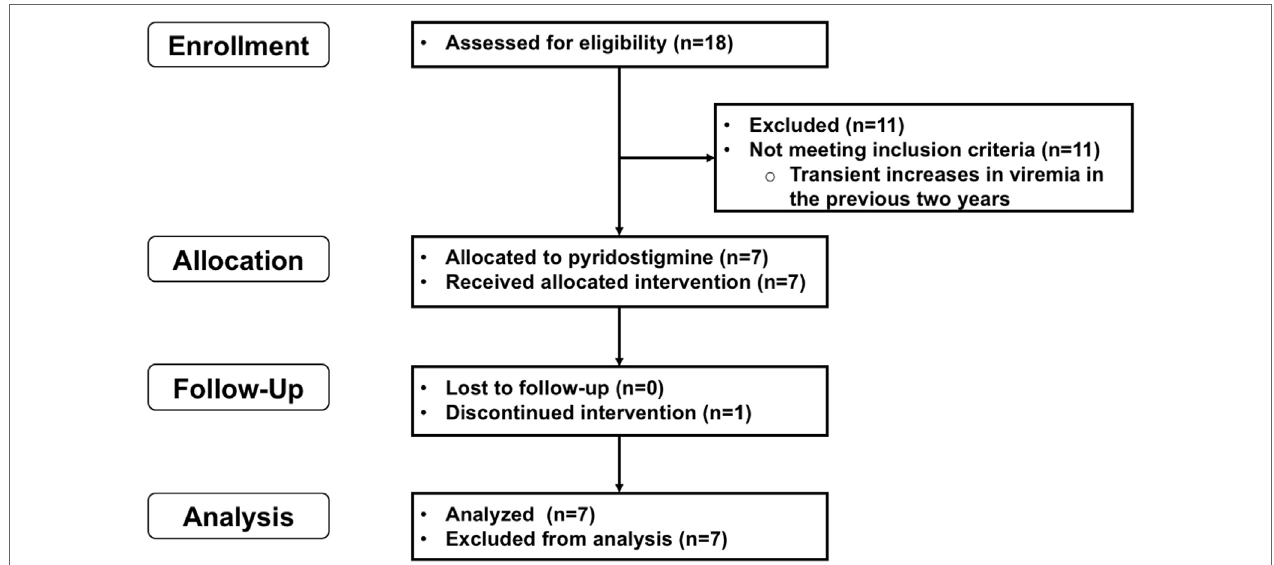
FigurE 1 | CONSORT flowchart of patient enrollment, follow-up, and